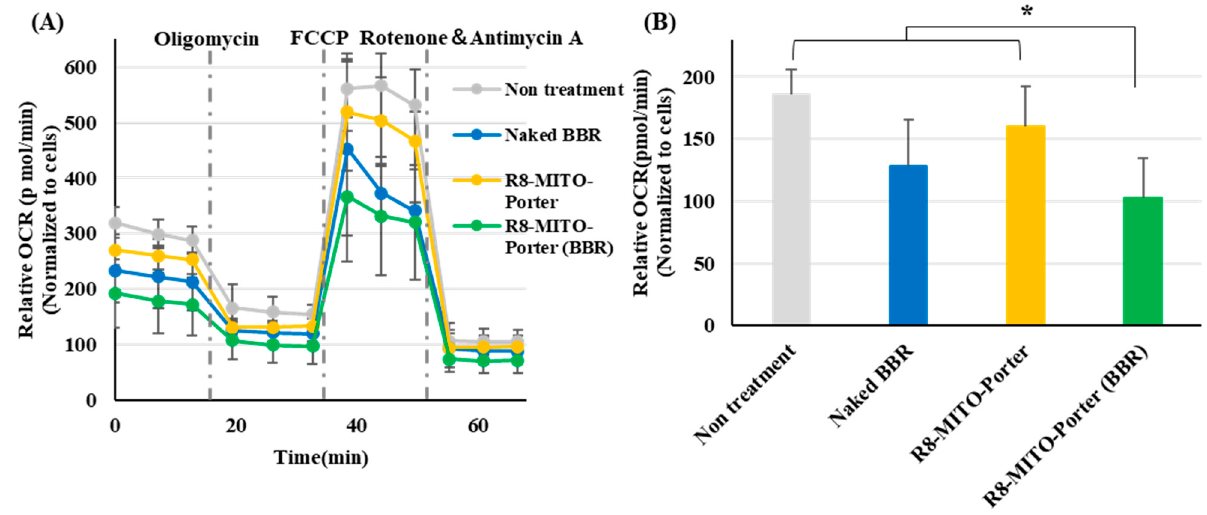
Figure 4. Evaluation of mitochondrial respiration function. Mitochondrial respiration function was evaluated using a SeahorseXFp analyzer at 4 h after treatment with these samples. ( A ) After the determination of OCR, the cells were sequentially treated with Oligomycin (1 µM), FCCP (2 µM), and rotenone plus antimycin A (0.5 µM). OCR was calculated by normalizing based on cell numbers. Data are represented as the mean ± S.D. ( B ) Basal OCR was calculated by normalizing using cell numbers. Data are represented as the mean ± S.D. (n = 4). * p < 0.05, one-way ANOVA followed by Student–Newman–Keuls test.